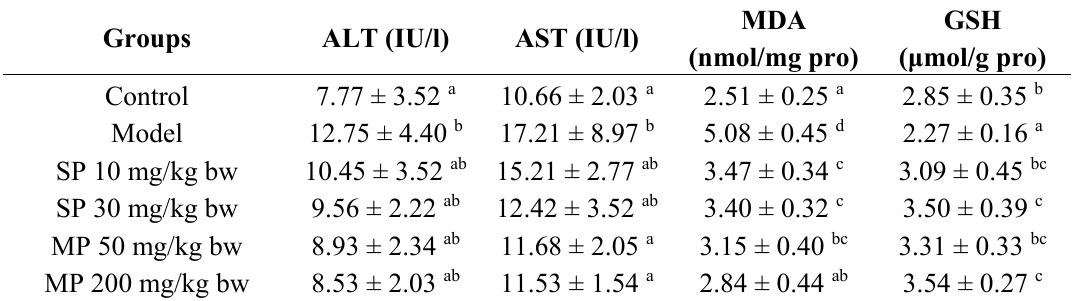
Table 1. Effects of peptides on serum AST, ALT activities, hepatic MDA and GSH. Groups